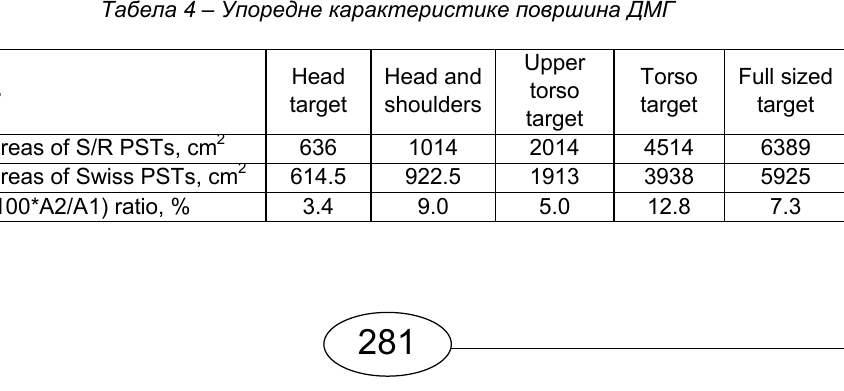
Table 4 – Comparative characteristics of the PST